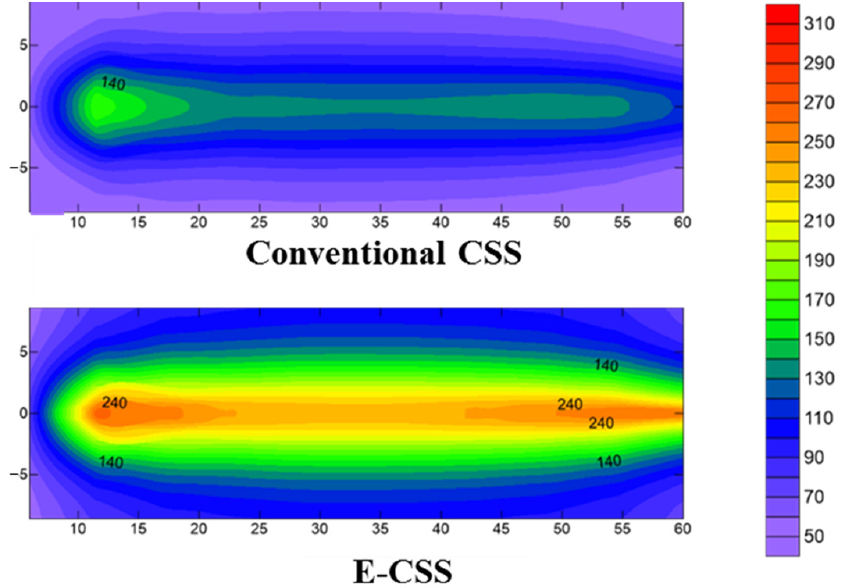
Figure 5. The comparison of the temperature field at the end of the second cycle soaking phase. (3) The mechanism of electric heating in the production phase Figure 6 displays the comparison of the temperature field at the middle of the second cycle production phase. From Figure 6, the comparison of the temperature field in the middle of production shows that, during the conventional CSS process, the temperature of the oil layer continued to decline to about 78 ◦ C with the continuous heat diffusion of the oil layer and the heat that was taken away by the output fluid. However, the temperature of the oil layer near the wellbore area continued to be kept above 140 ◦ C in E-CSS. This was because the continuous thermal compensation of the electric heater to the oil layer though the produced fluid drove a lot of heat away.